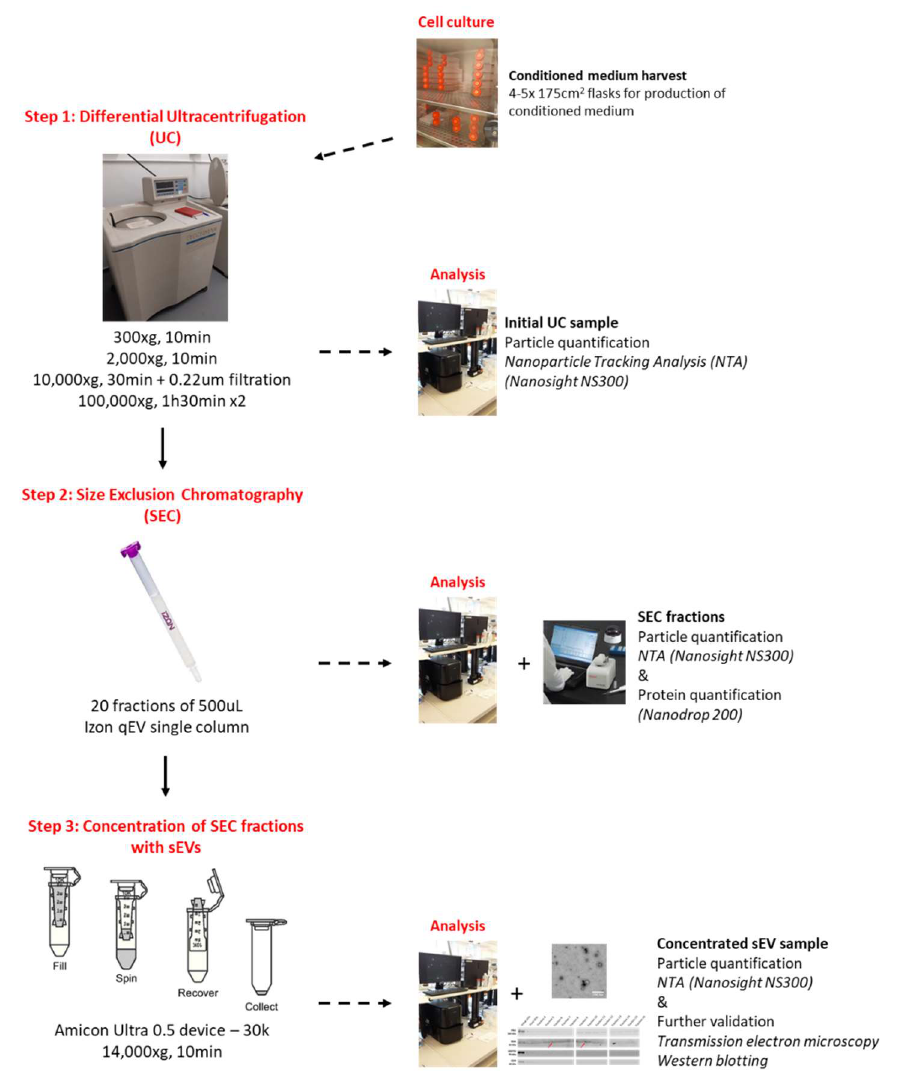
Figure 4. Three method-combination for concentrating EVs derived from cell culture medium.